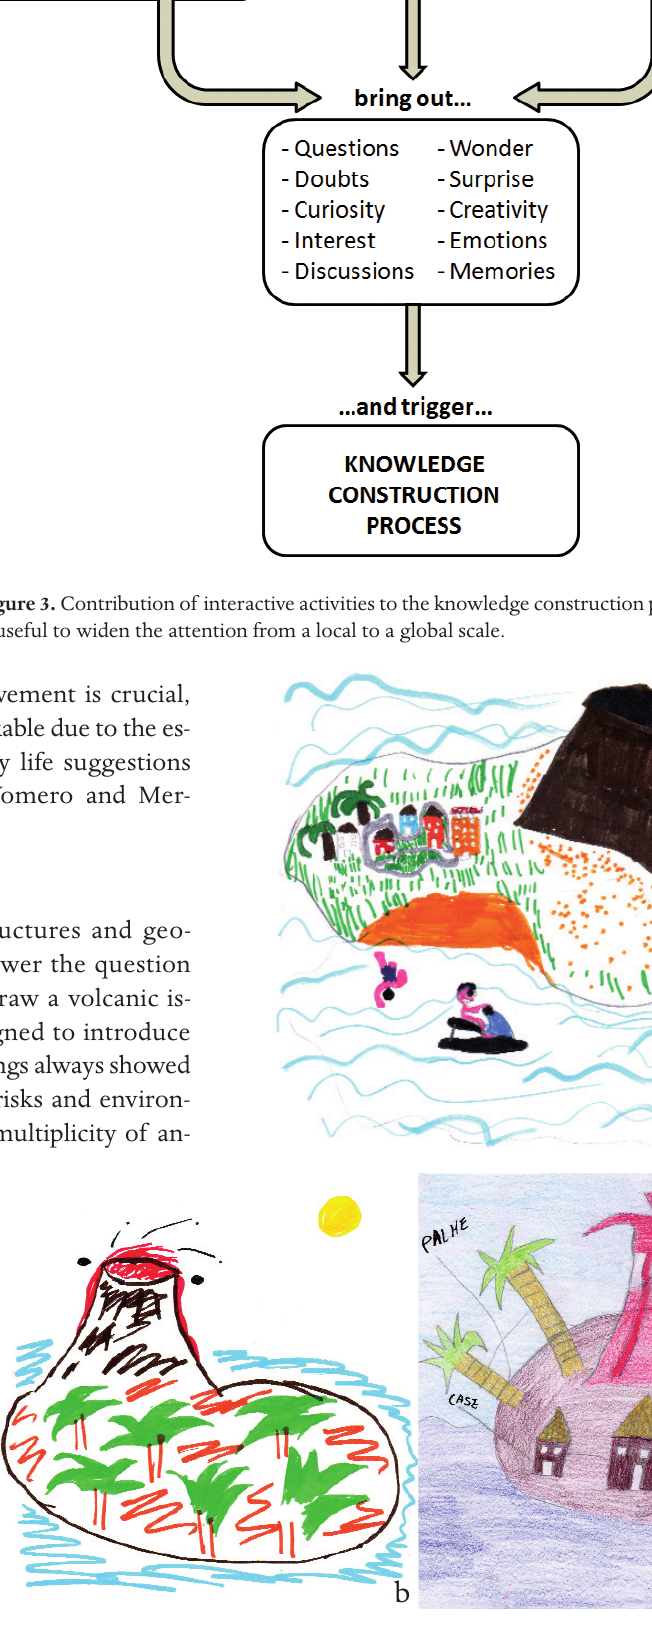
Figure 4. Selected drawings. (a) The attention is focused on the volcanic structure and its activity. (b) The eruption and the vegetation are the main subjects in this drawing. (c) Volcanic activity and human settlements stimulated a discussion of the volcanic risk. (d) The presence of a tourism site allowed talk about the environmental impact on the